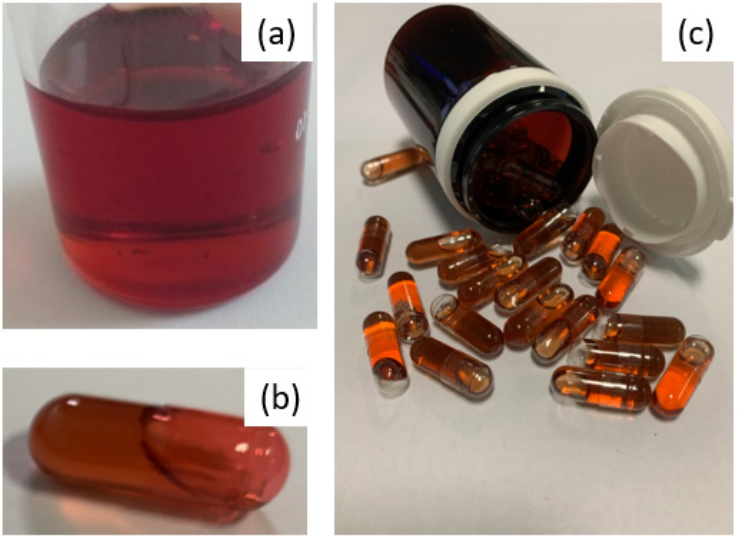
Figure 1. ( a ): appearance of the fill before division into capsules. ( b ): capsule comprising 400 of EGCG. ( c ): typical containers for one month’s treatment.